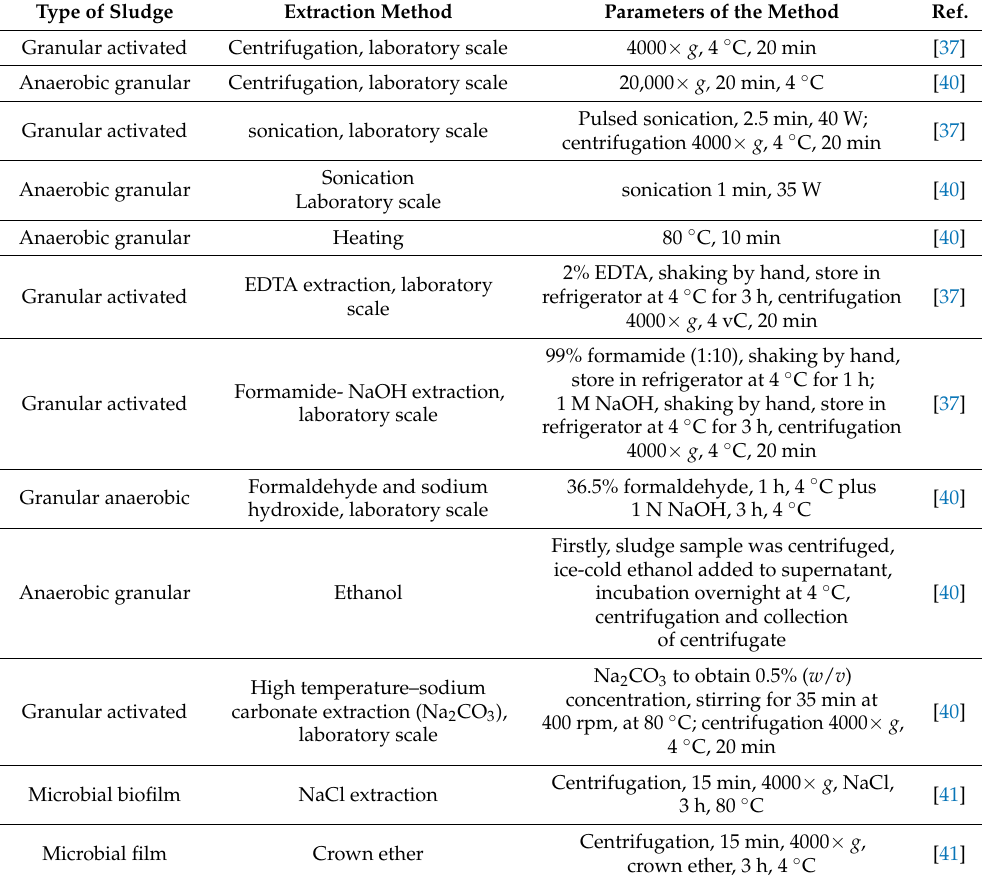
Table 2. Technological parameters of selected EPS extraction from the